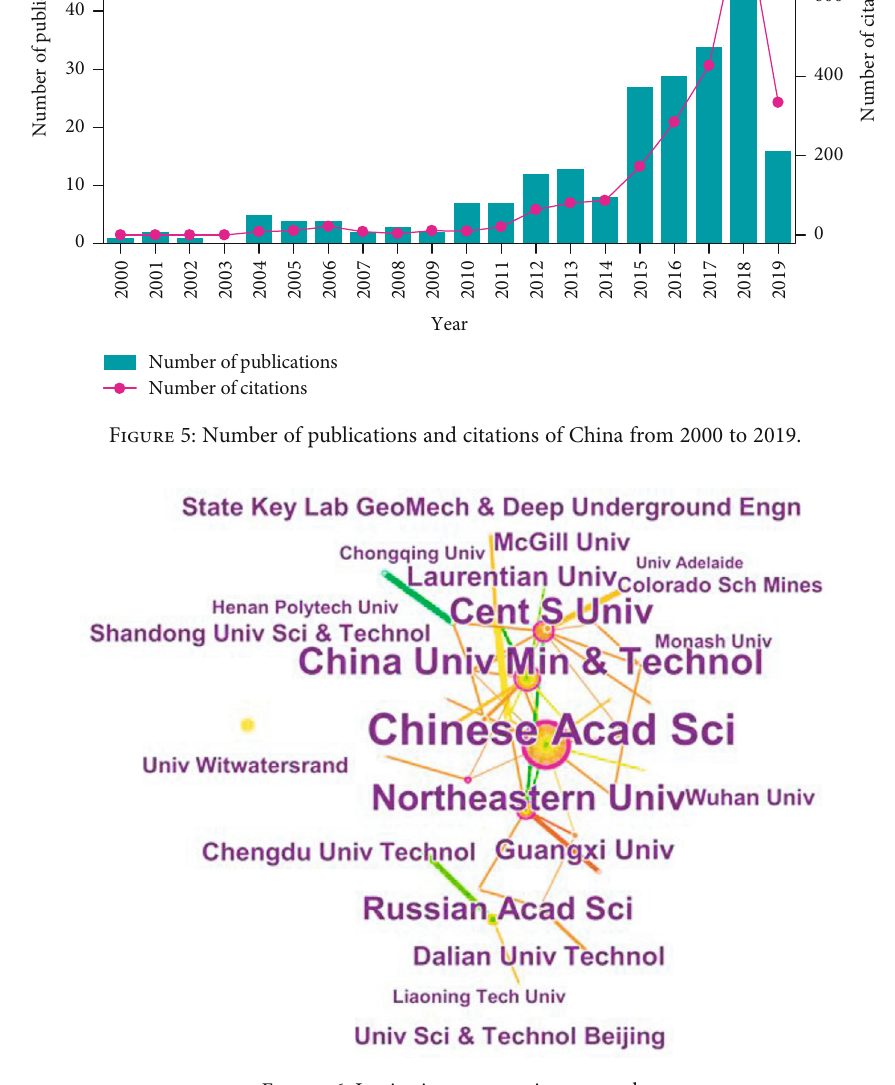
Figure 8. In this network, the size of keywords is proportional to the occurrence frequency. Keywords with a frequency